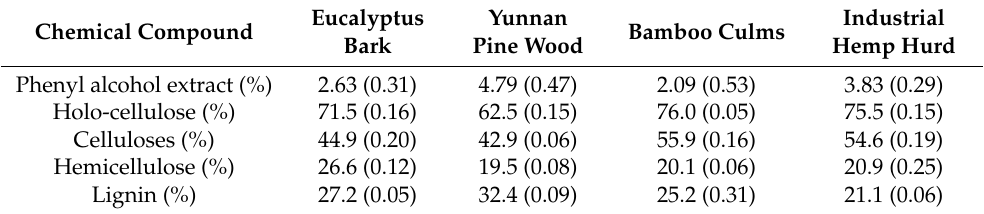
Eucalyptus Yunnan Industrial Bamboo Culms Bark Pine Wood Hemp Hurd